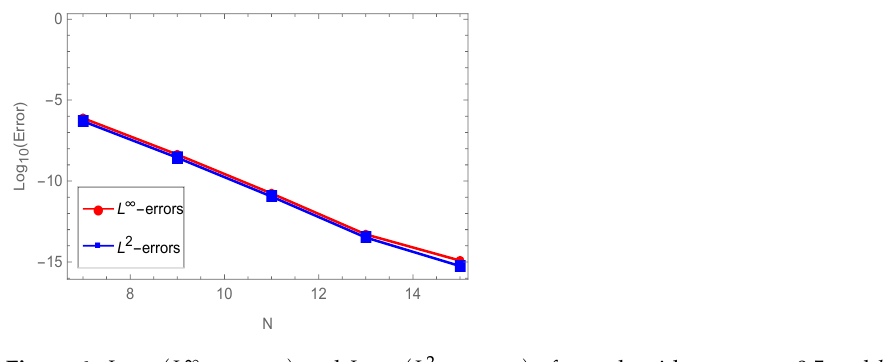
Figure 6. Log 10 ( L ∞ − errors ) and Log 10 ( L 2 − errors ) of our algorithm at υ 1 = 0.5 and b = 0 with distinct N for Example 3.